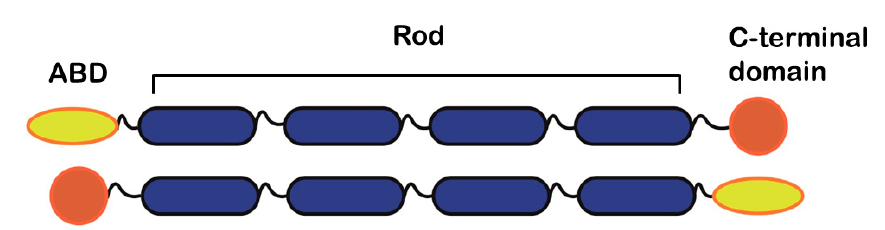
Figure 1. Schematic diagram illustrating the molecular organization of alpha-actinin. Relevant regions / domains (actin-binding (ABD), central rod and C-terminal domains) are highlighted.